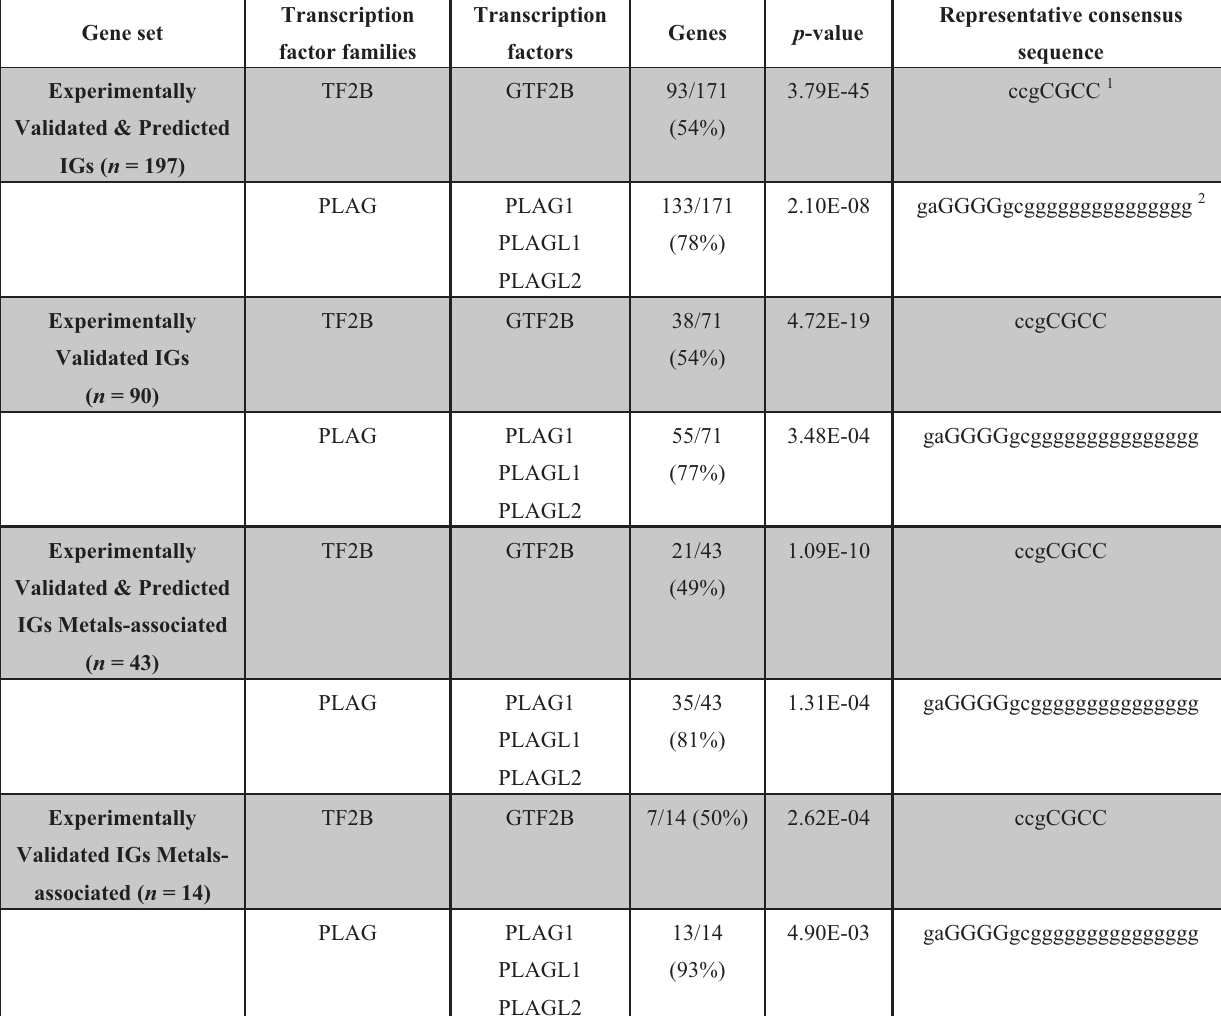
Table 2. Enriched transcription factors amongst the imprinted gene